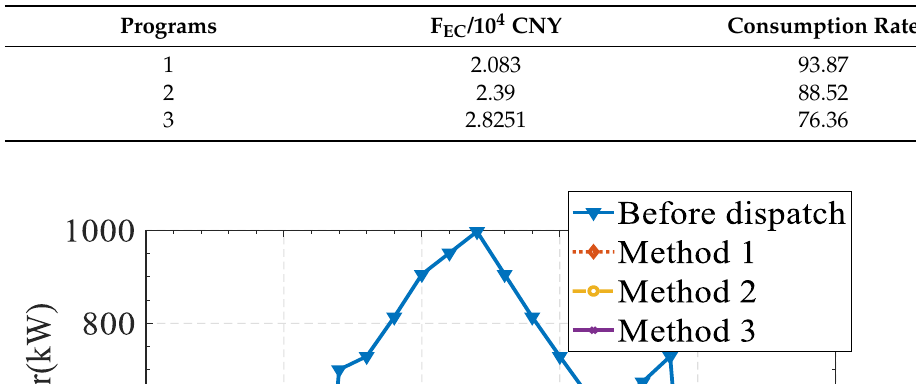
Table 6. Operating cost and consumption rate.